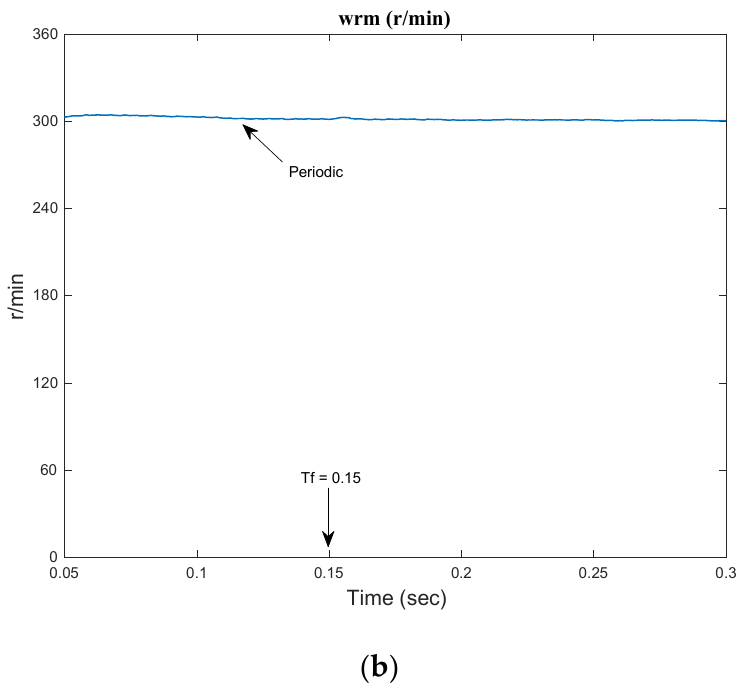
Figure 25. Simulated multiple faults when the a -phase leg was open-circuited and the a -phase current sensor was faulty using the periodic speed-loop controller: ( a ) current; ( b ) speed.